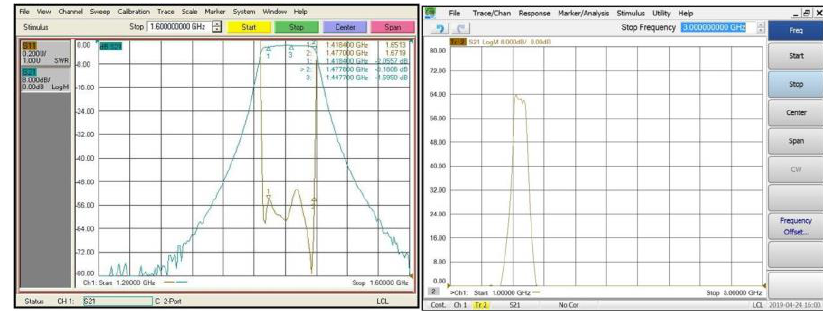
Fig. 3. The band pass filter and amplifaer amplitude friquence diagrams.